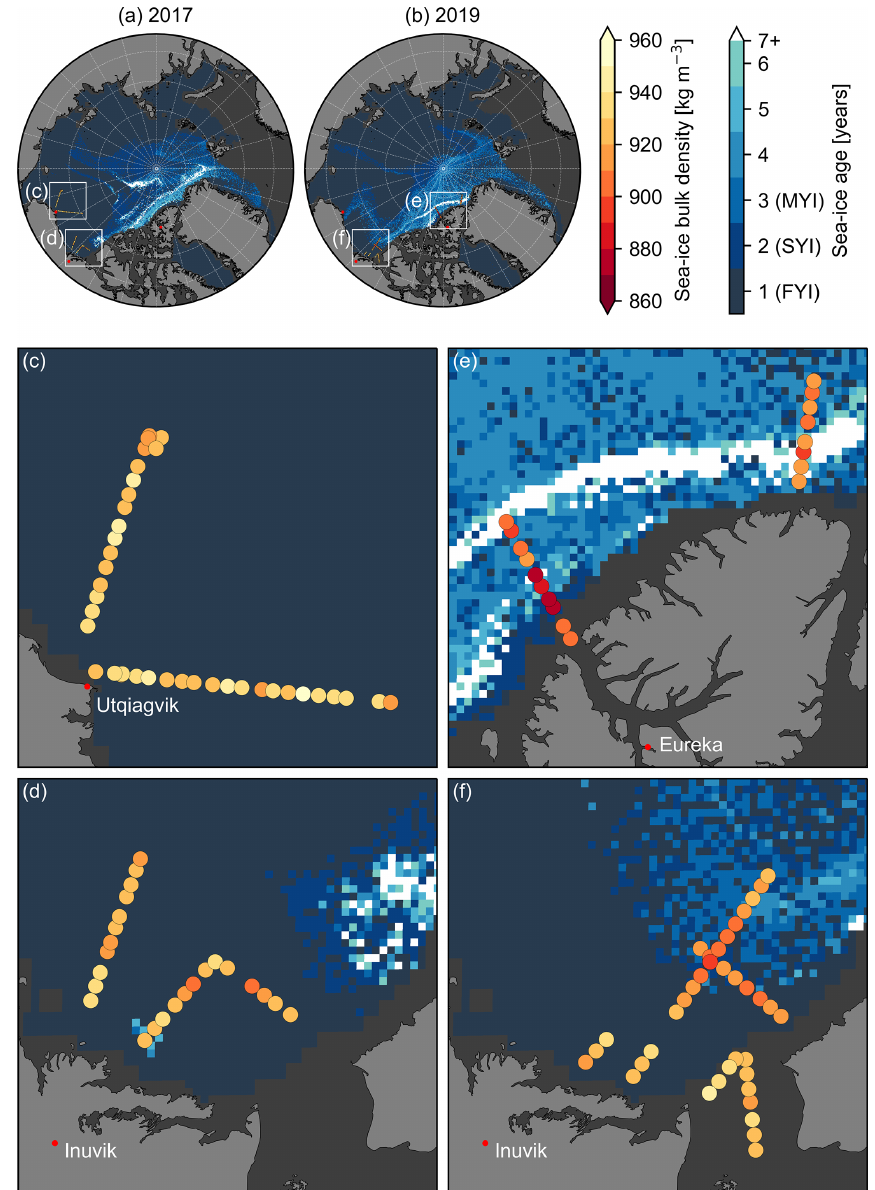
Figure 7. Sea-ice bulk density in 25km along-track segments shown as coloured circles over the weekly NSIDC EASE-Grid Sea Ice Age product (2–8 April; Tschudi et al., 2019) in bluish colours in 2017 (panels a and c – d ) and in 2019 ( b and e – f ). The close-up panels (c) – (f) are 700km × 700km in size, and their locations are marked with white squares in the overview panels (a) and (b)